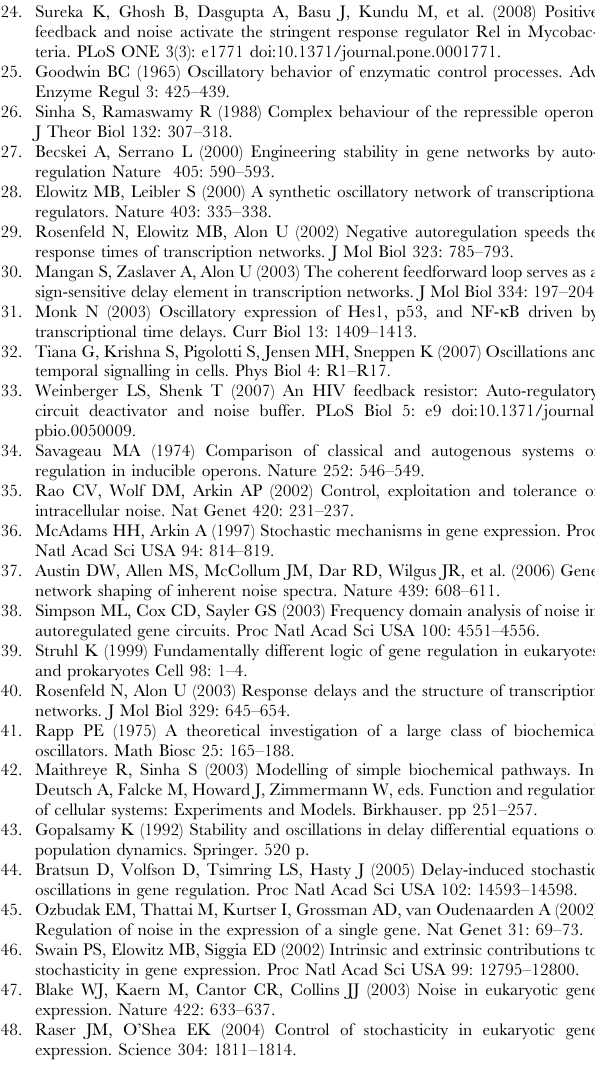
Table S1 Comparison of kc value with k values from Nyquist loci for increasing delay.